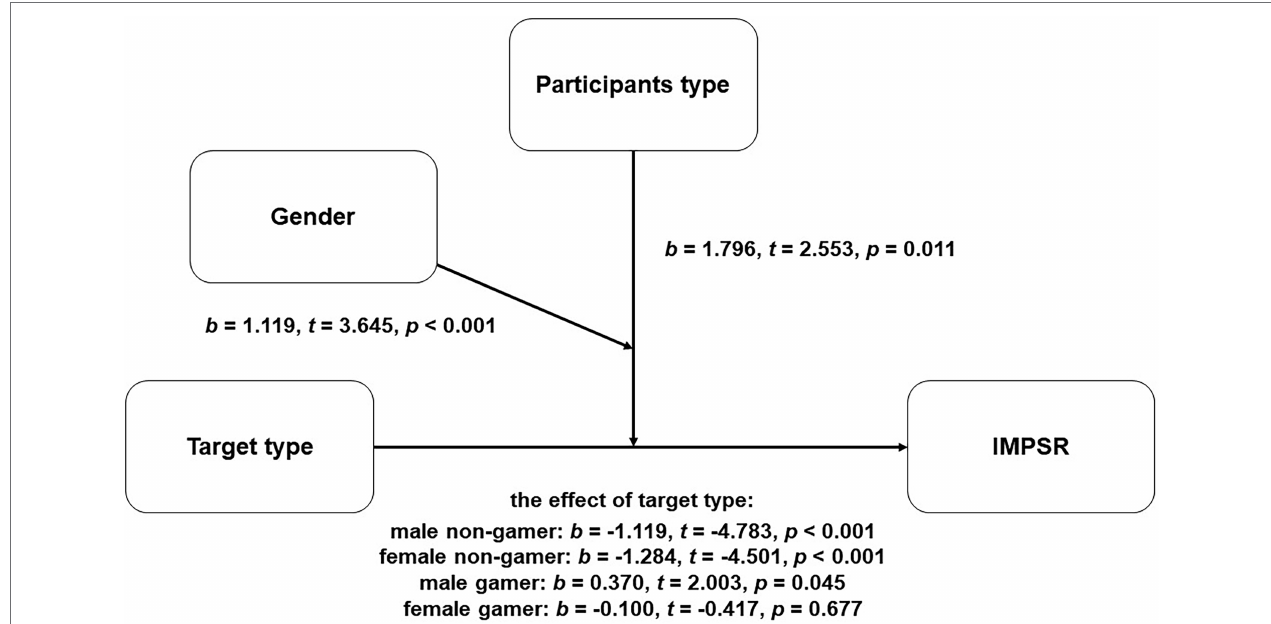
FIGURE 1 | The moderating effect model of participant type (gamer or non-gamer). IMPSR, ideal marriage partners similarity